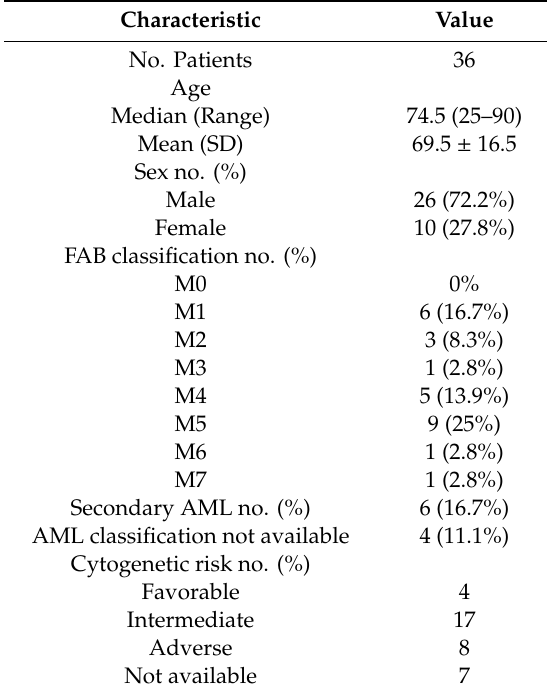
Table 2. Clinical characteristics of patients with